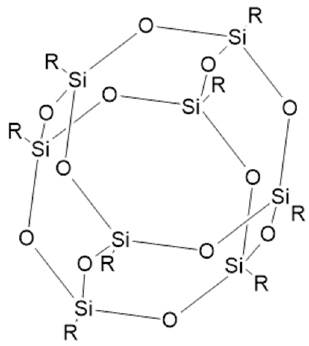
Figure 8. A structure of polyhedral oligomeric silsesquioxanes (POSS) [128].